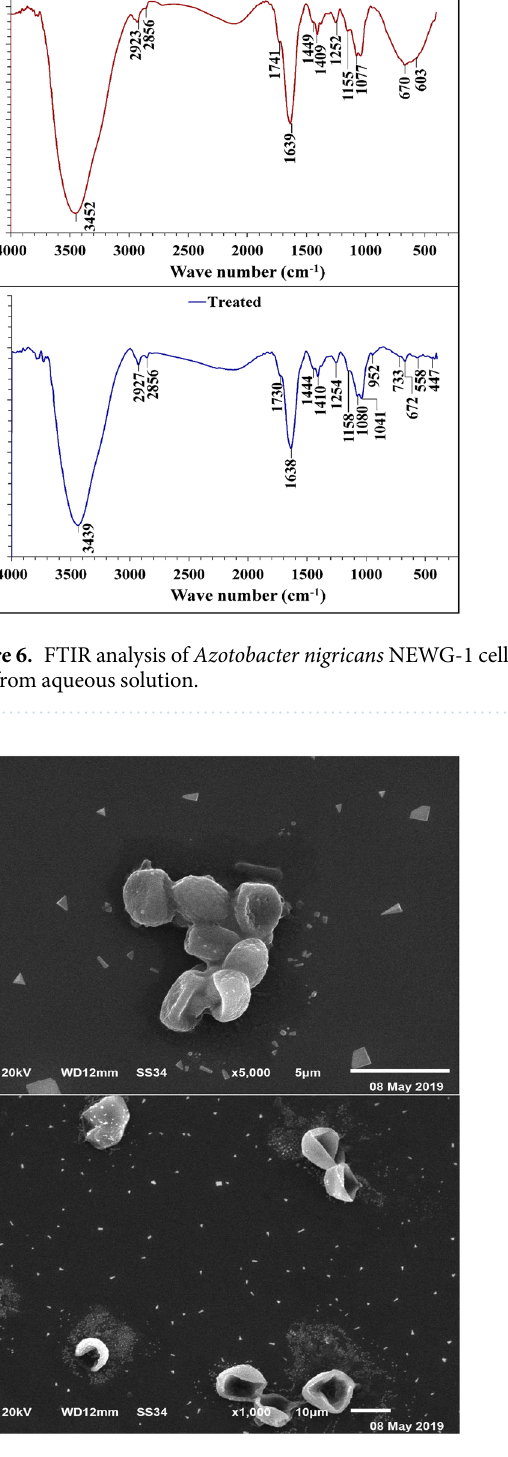
Figure 7. SEM micrograph of Azotobacter nigricans NEWG-1 cells: ( A ) before and ( B ) after biosorption of Cu 2 + ions from aqueous